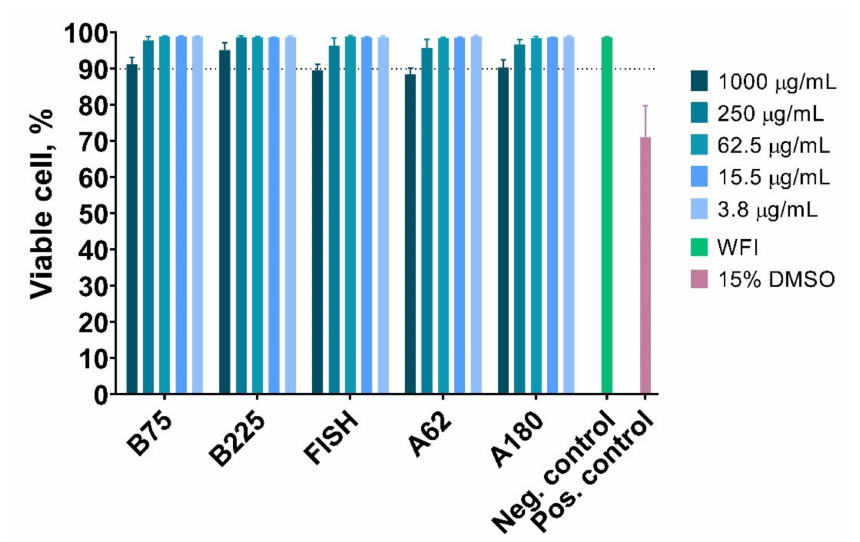
Figure 12. Viability of PBMC in the presence of various concentrations of gelatin nanoparticles. WFI—water for injection. PBMC from three volunteers were obtained, mean ±